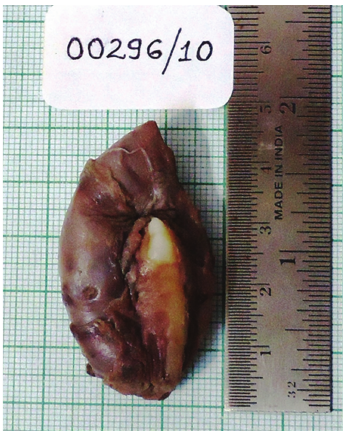
Figure 4: Gross examination revealed a cystic lesion showing the attachment of embedded canine